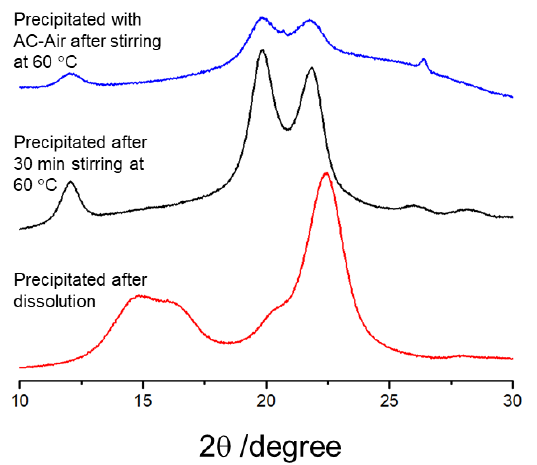
Figure 5. X-Ray diffraction patterns of cellulose precipitate after dissolution in H 3 PO 4 under differ- ent conditions. ent